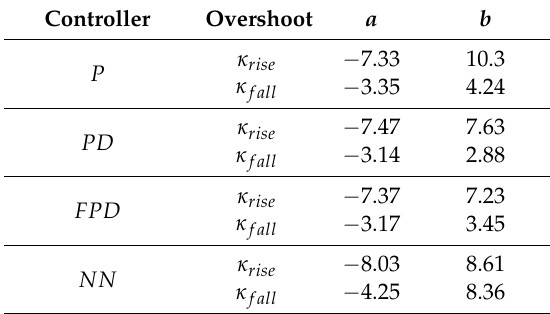
Table 4. Coefficients of approximations of overshoots versus filter time constant